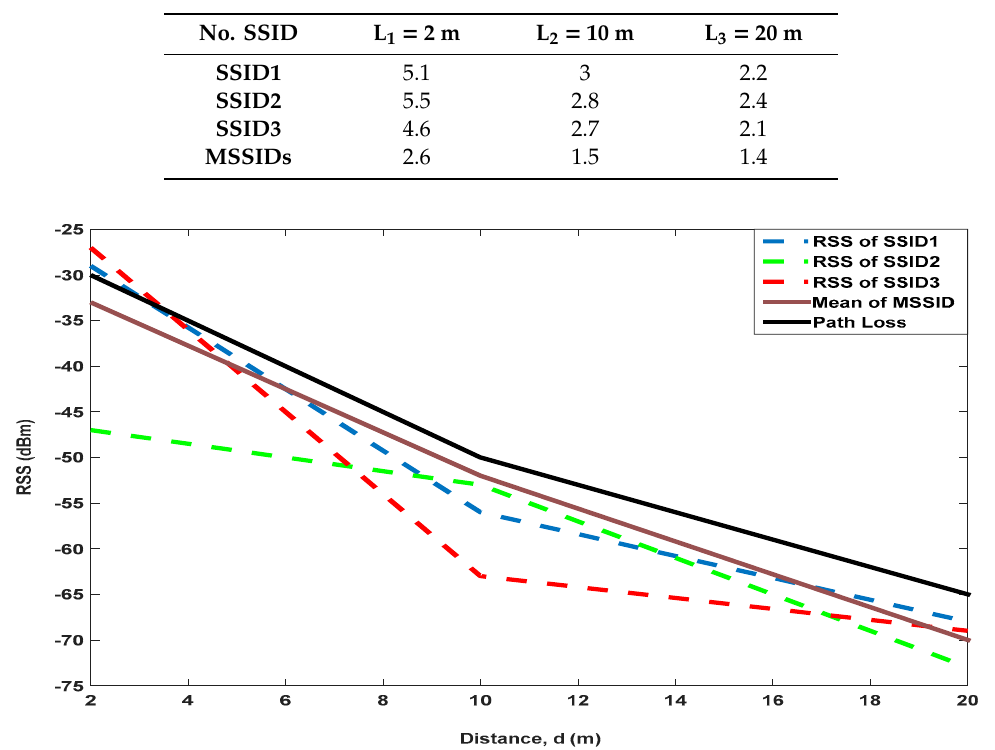
Table 4. The Standard Deviation of MSSID signals versus distance (m).